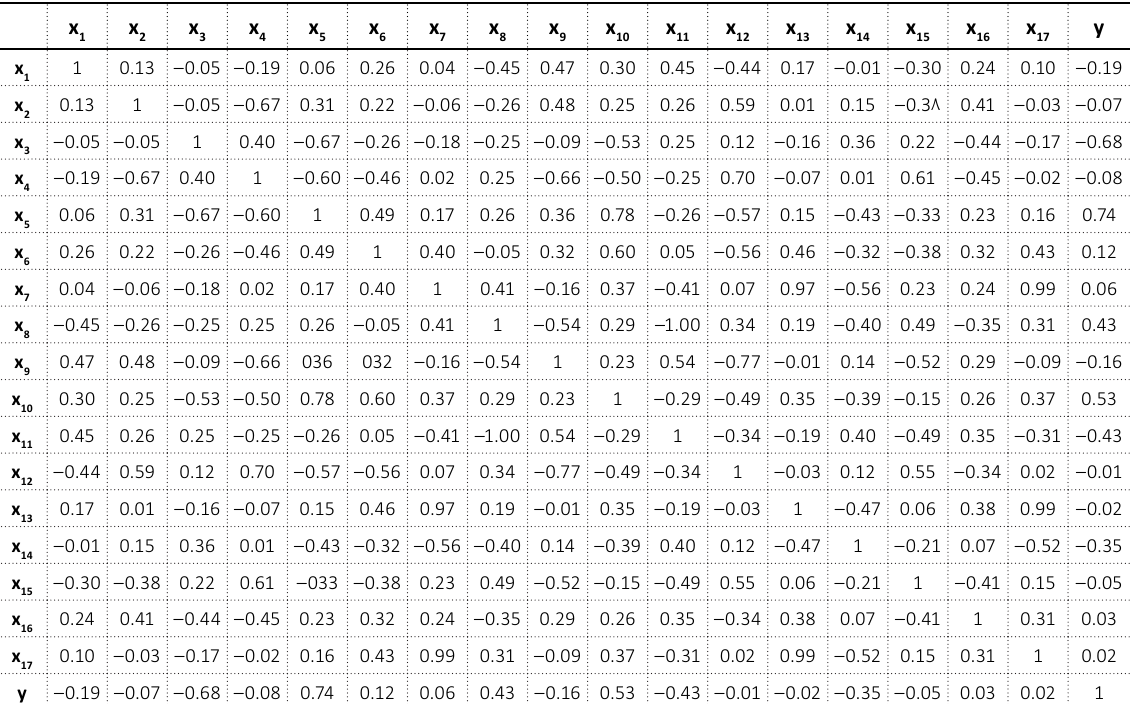
Source: Own processing, Databank, World Bank, World Development